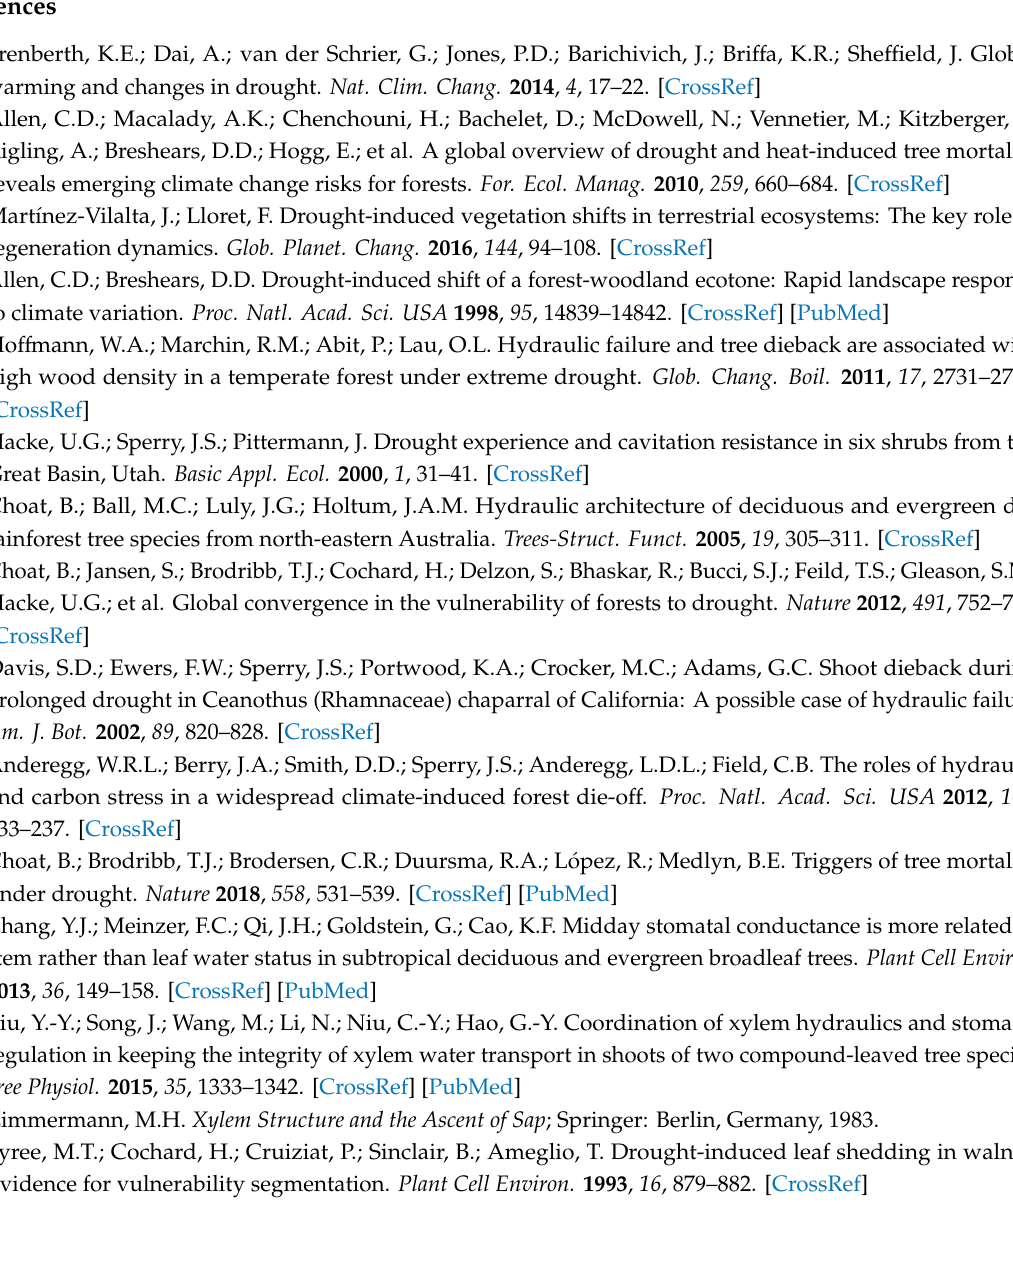
Table S1: Characteristics of tree species included in this study, Table S2: Hydraulic and photosynthetic traits of the tree species in this study, Table S3: Factor loading, eigenvalues, the percentage of functional traits explained by the first two principal components, Figure S1: The monthly air temperature, monthly precipitation and soil water content in our study from 2012–2017, Figure S2: Leaf vulnerability curves for the six tree species in this study, Figure S3: Stem vulnerability curves for the six tree species in this